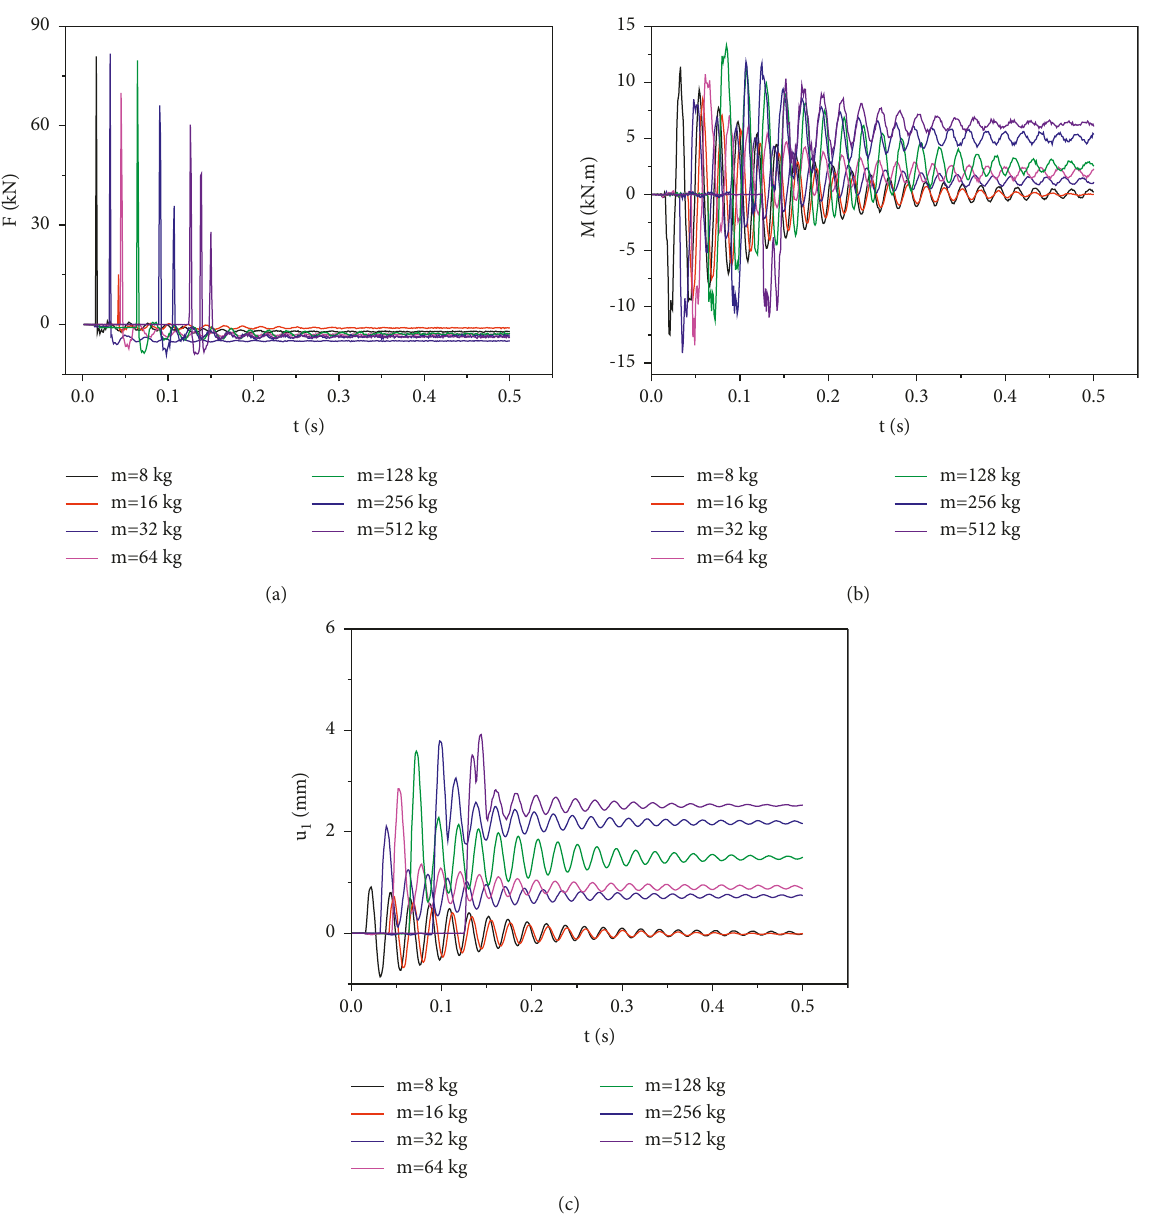
Figure 8: Dynamic response when Ek � 0.04kJ. (a) F- t ; (b) M- t ; (c) u1- t